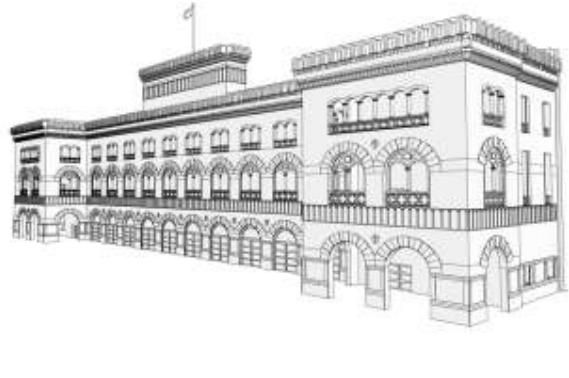
Figure 7. 3D Model of Provisional Parliament room by Amedeo Payron, F. Giusti I. Giai Via, A. Quarati,